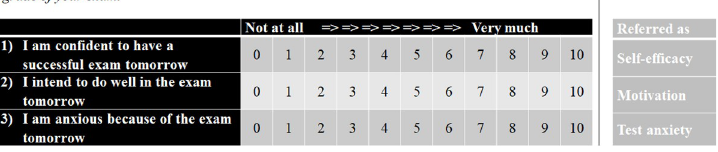
Fig 4. Questions students answered before their first and second